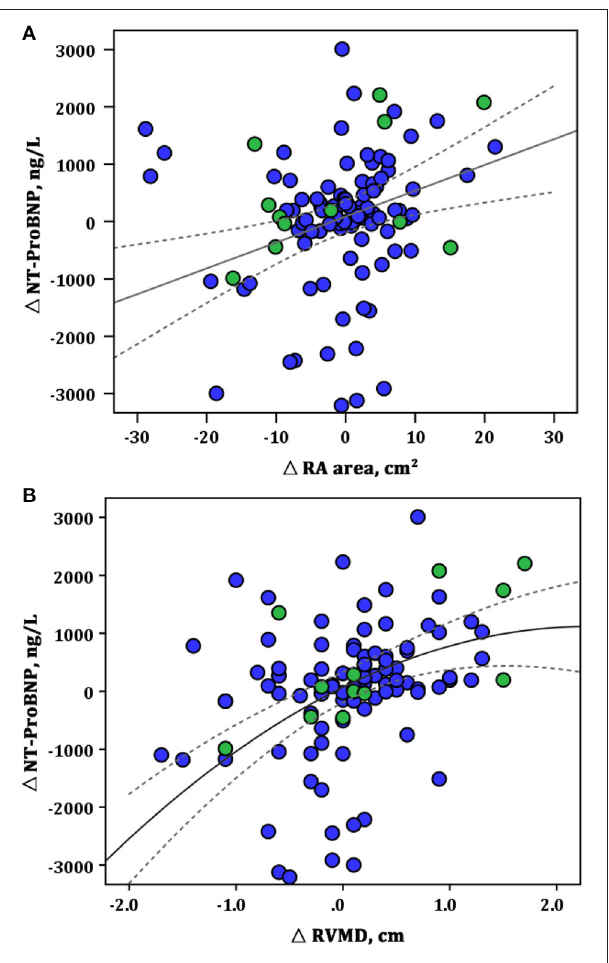
FIGURE 2 | Correlations between the changes in RA area, RVMD, and NT-proBNP at the first follow-up assessment. (A) 1 RA area vs. 1 NT-proBNP (linear model: r 2 = 0.51, p = 0.009); (B) 1 RVMD vs. 1 NT-proBNP (linear model: r 2 = 0.45, p = 0.001). Green circles represent the patients with ARHR; blue circles, without ARHR. NT-proBNP, N-terminal fragmental of pro–brain natriuretic peptide; RA, right area; RVMD, right ventricular mid diameter.